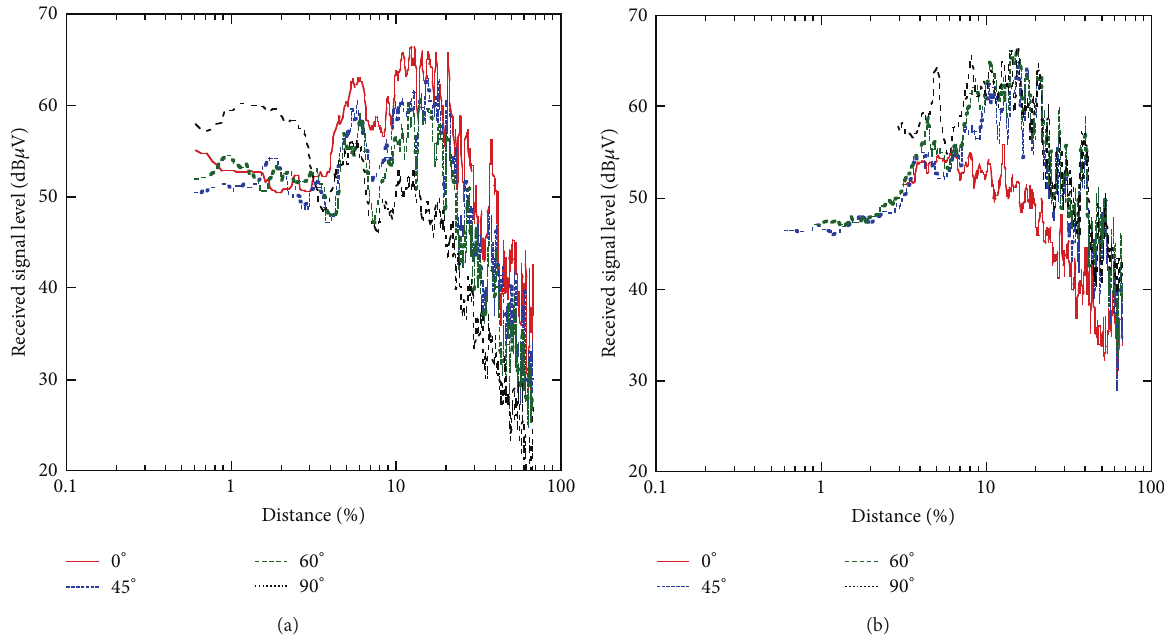
Figure 19: Received-signal level. (a) Collinear with tilt beam (V tilt antenna). (b) DSCA array with tilt beam (H tilt antenna).